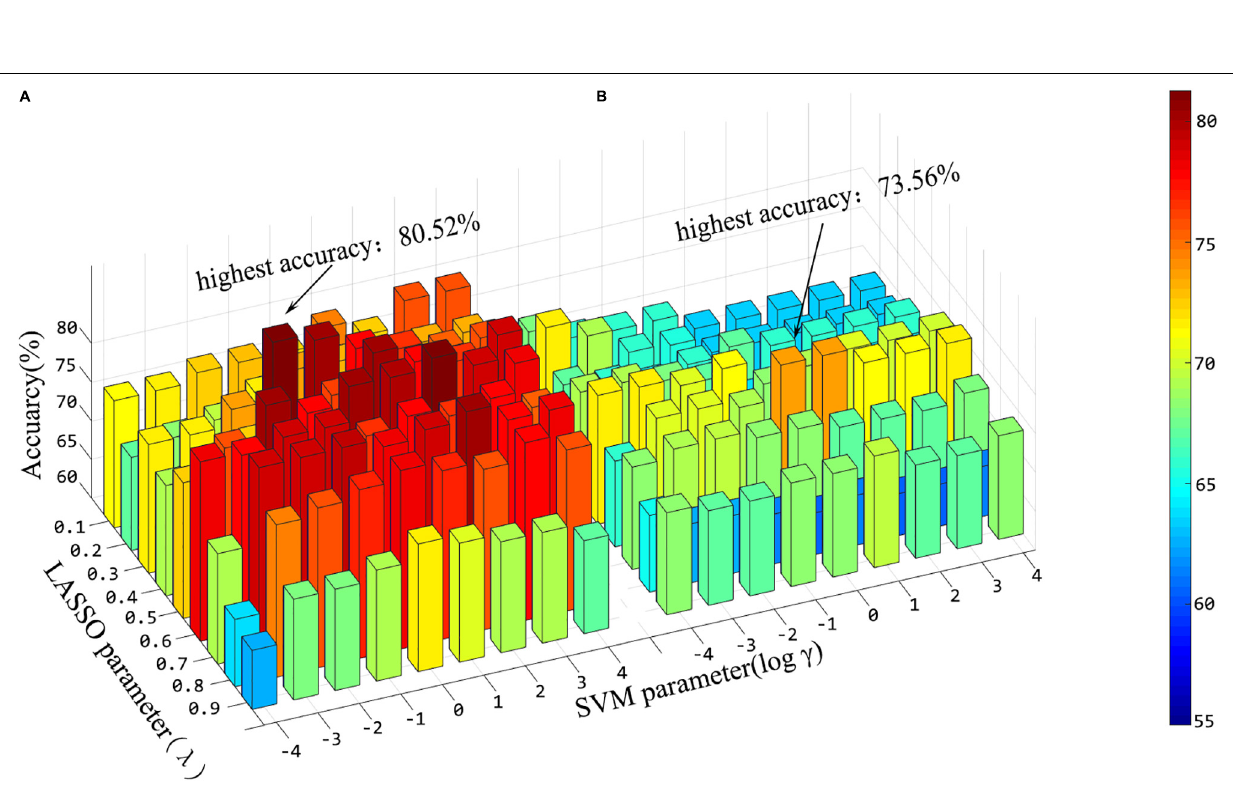
Frontiers in Neuroscience |